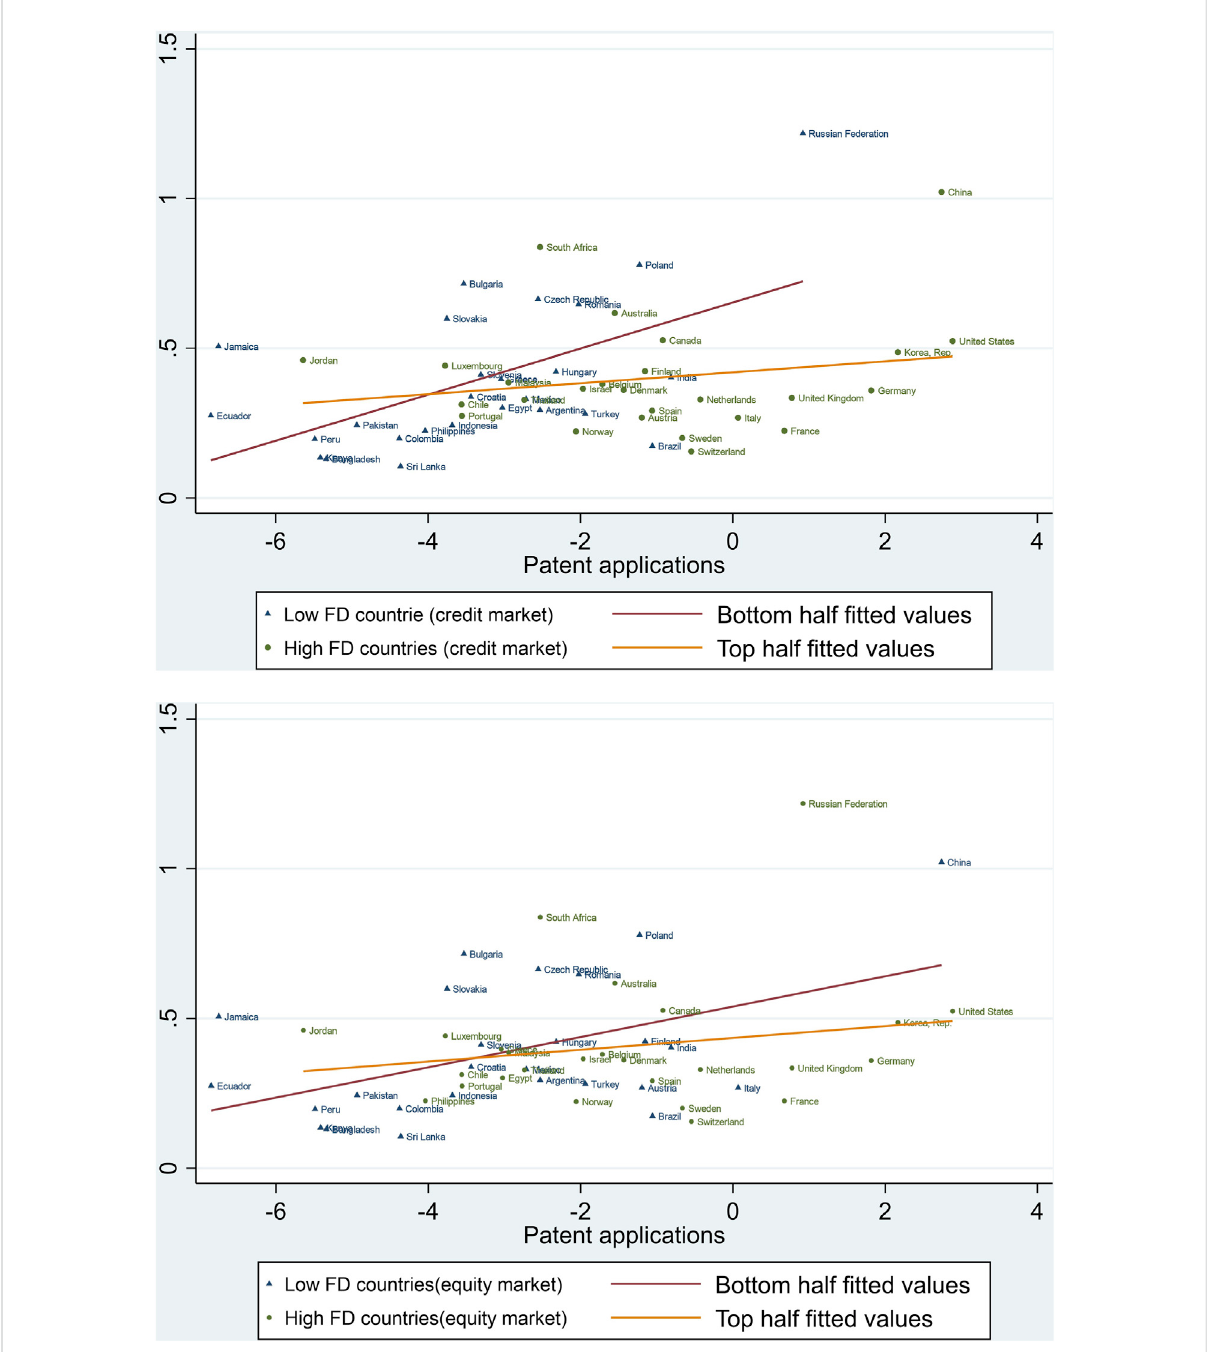
FIGURE 1 Financial development and innovation-pollution nexus. The countries are categorized by the level of credit market development and equity market development speci fi cally. The countries are divided into two categories, low and high FD